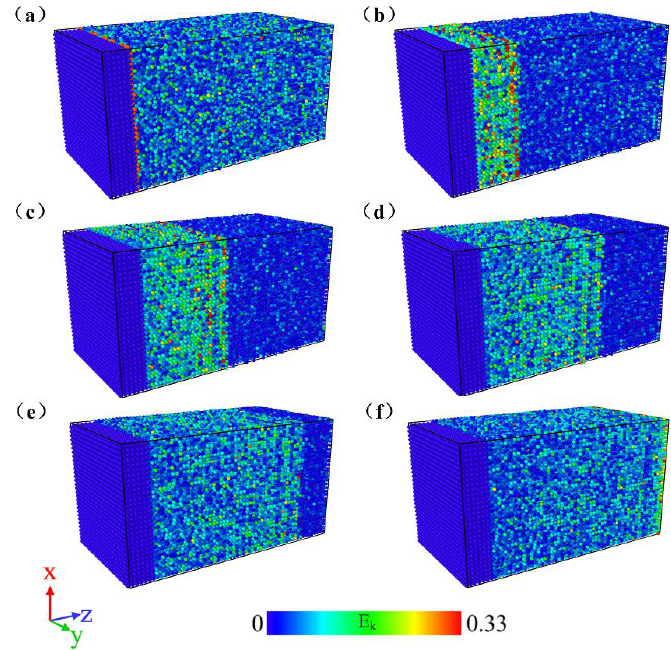
Figure 7. Propagation trajectory of the shock wave in NiTi SMA: ( a ) t = 0.0 ps; ( b ) t = 0.6 ps; ( c ) t = 1.2 ps; ( d ) t = 1.8ps; ( e ) t = 2.4 ps; ( f ) t = 3.0 ps. Materials 2018 , 11 , x FOR PEER REVIEW